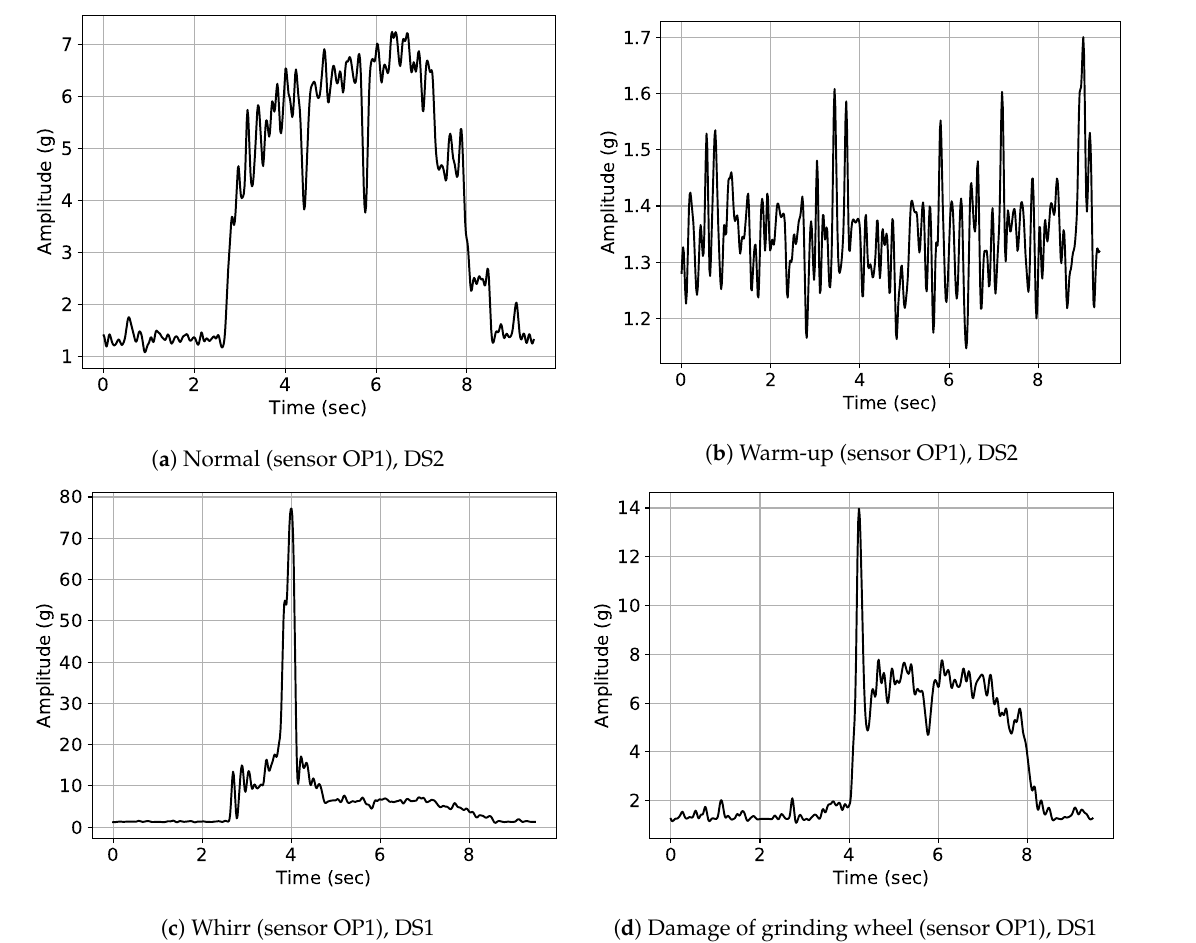
Figure 5. Exemplary envelope signals for different classes of anomalies, as seen during our deployment and annotated by expert operators: Damage of the grinding wheel occurred due to multiple, successive whirring workpieces. A detailed description of the different anomaly types can be found in Section